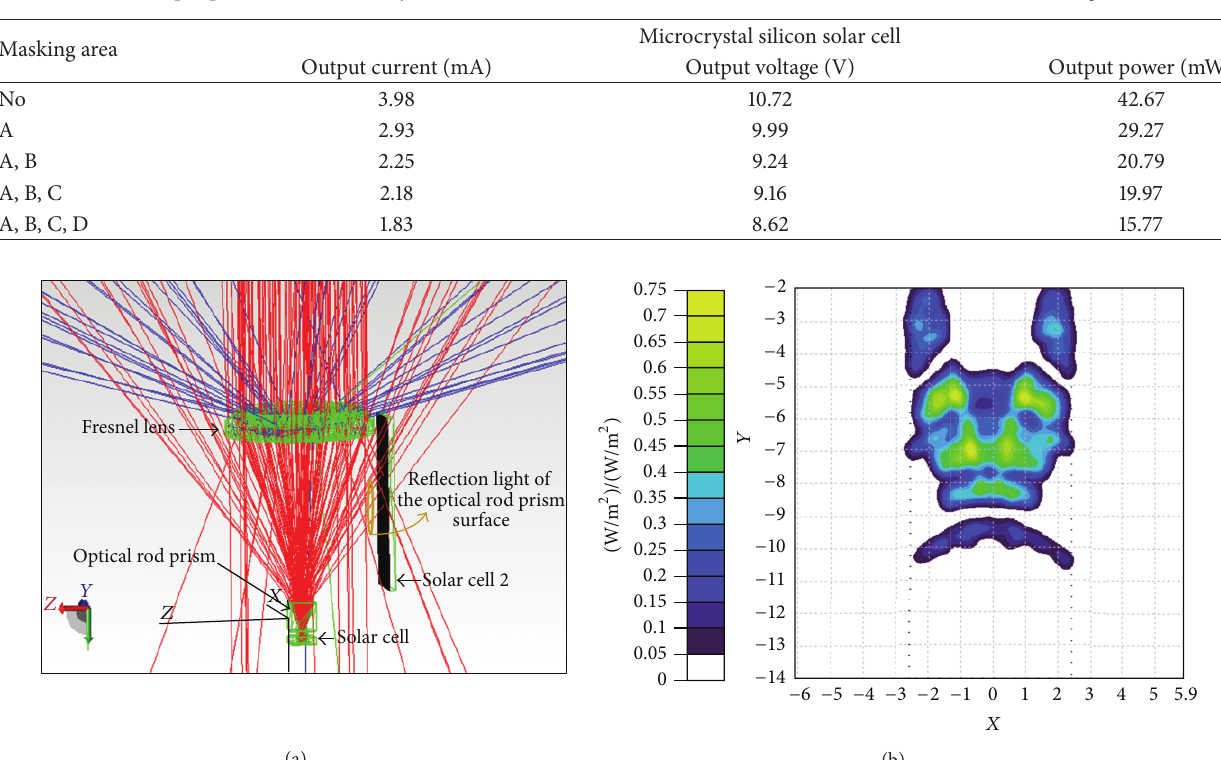
Table 3: The output power of the microcrystal side-wall silicon solar cell of Mechanism (D) under the different masking conditions.